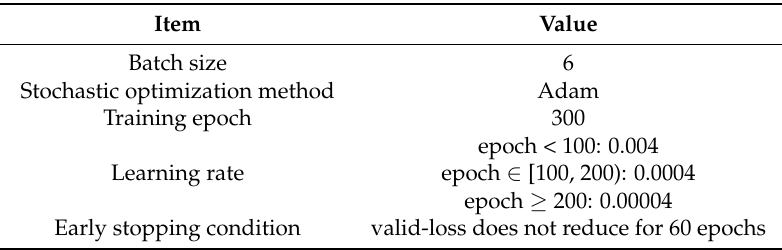
Table 4. Hyperparameter settings for the single shot multibox detector (SSD).